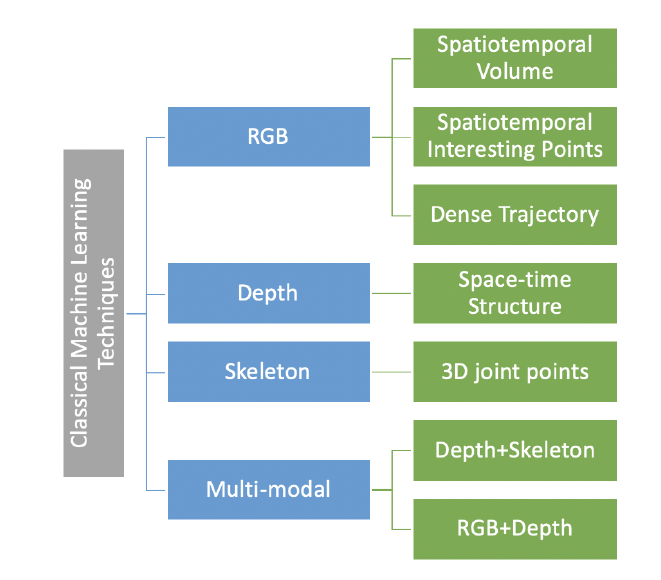
Figure 4. Hierarchy of action recognition techniques based on handcrafted features that use classical machine